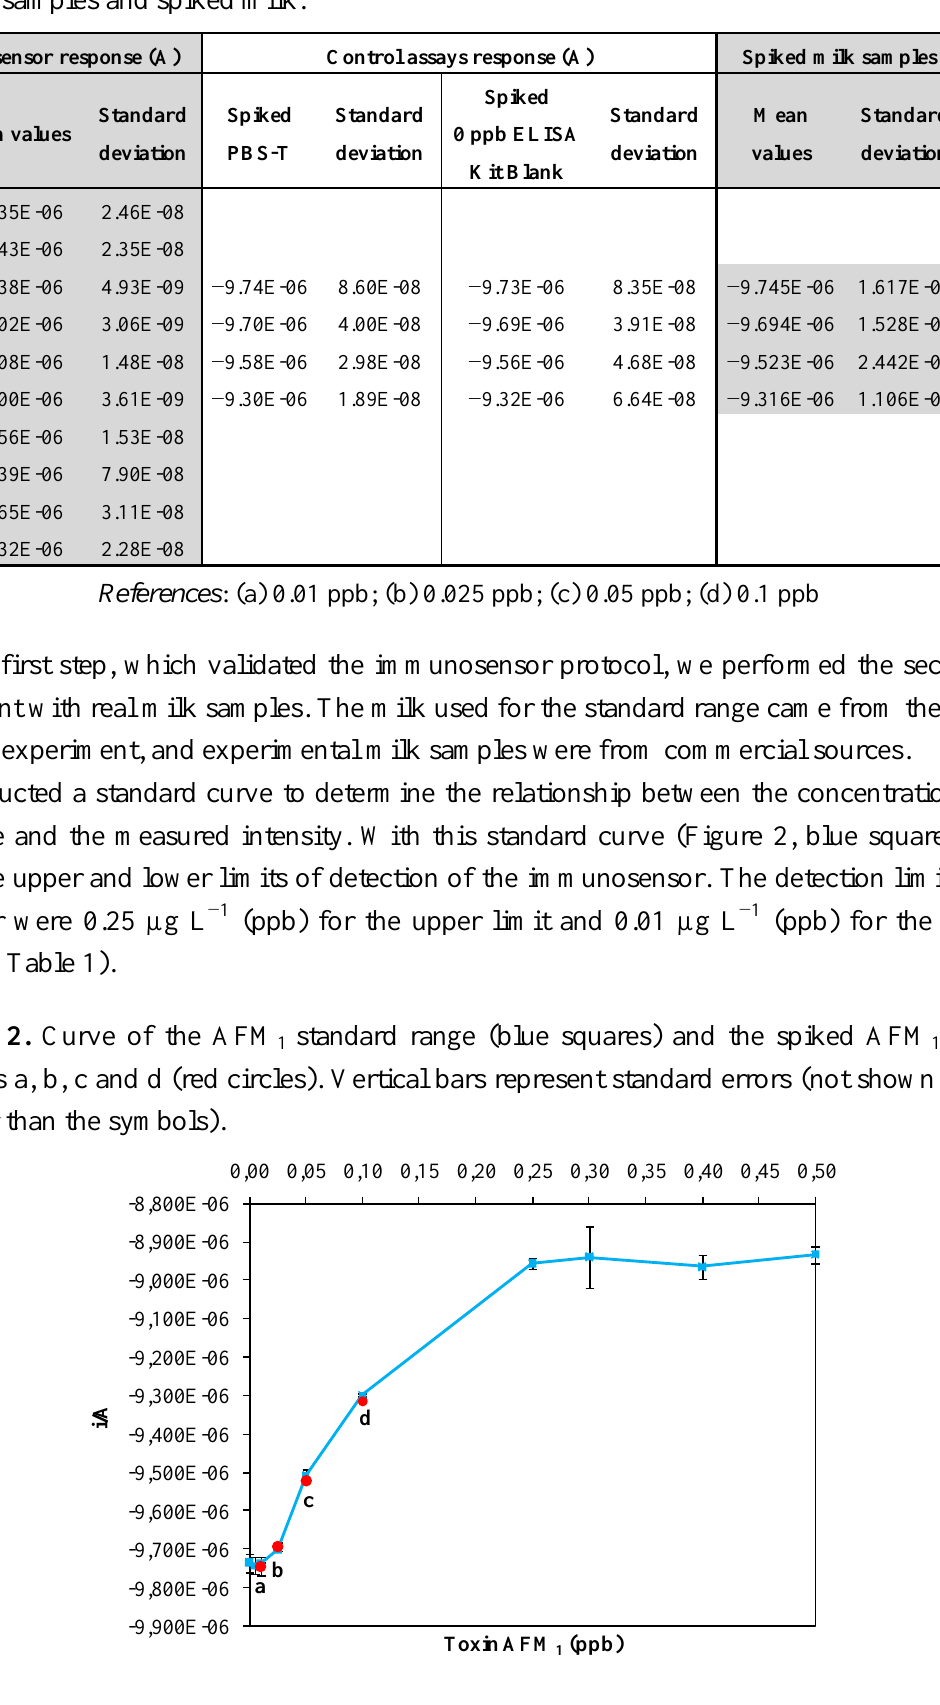
Table 1. Sensor calibration using standard solutions of AFM control samples and spiked milk.